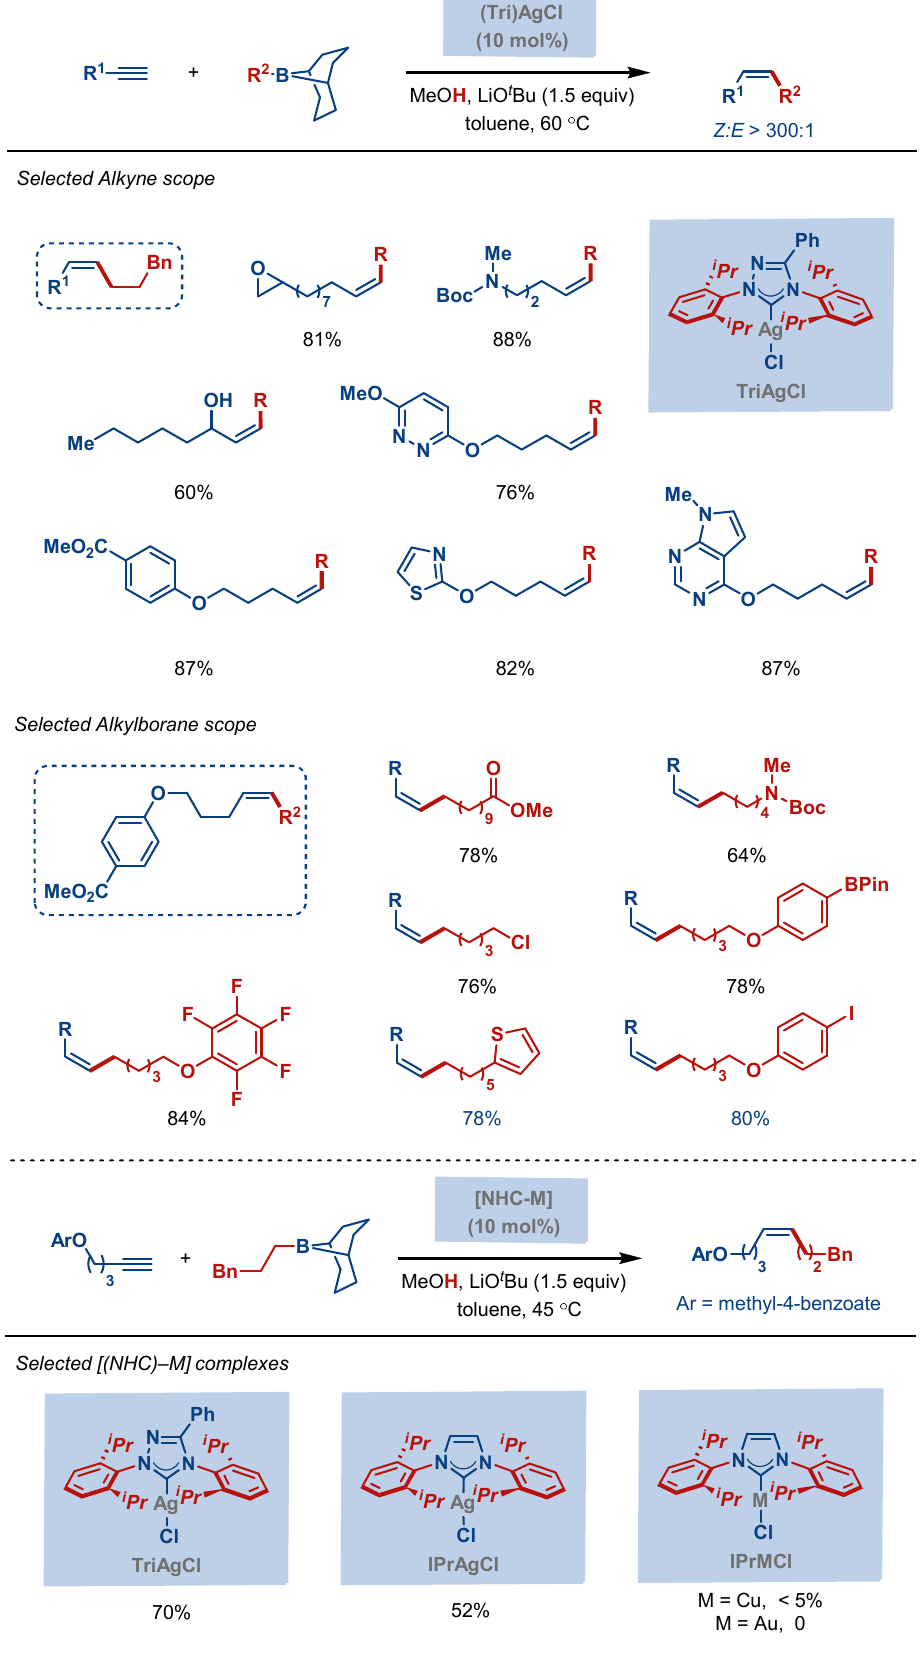
Scheme 17. Ag(I)−NHC-catalyzed hydroalkylation of alkynes, as reported by Lalic et al. [83] Scheme 17. Ag(I) − NHC-catalyzed hydroalkylation of alkynes, as reported by Lalic et al.